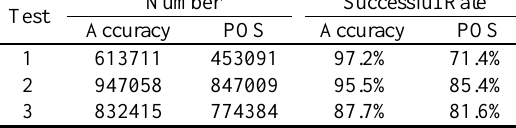
Table 2. Dense matching results comparison